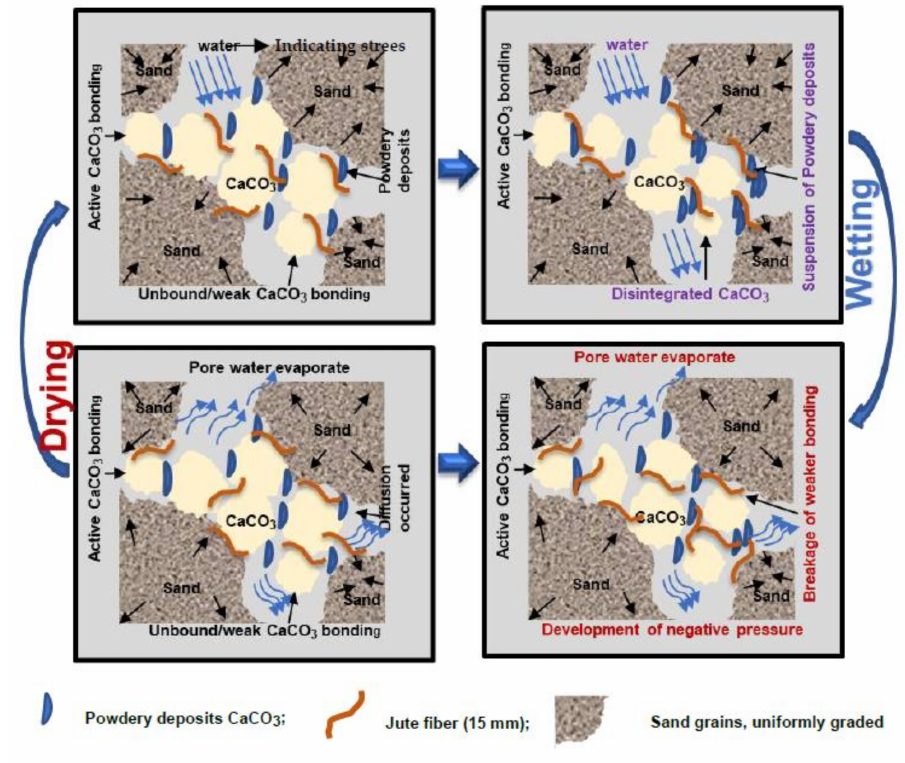
Figure 11. Schematic illustration of the deformation process of fiber-reinforced MICP-treated speci- mens after exposure to WD cycles. Position on the